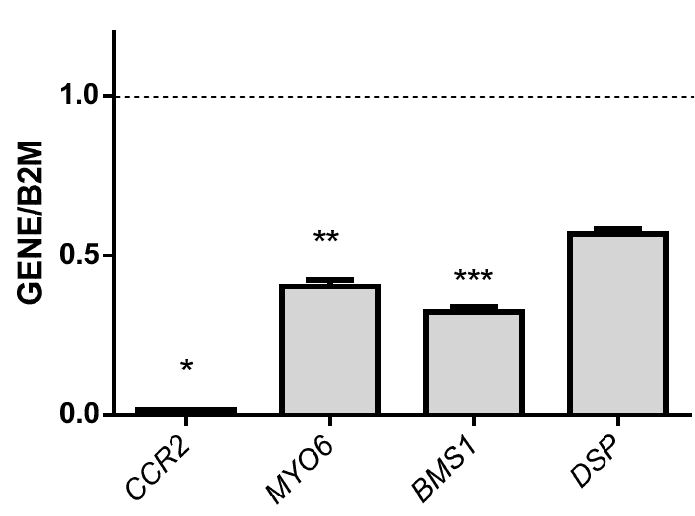
Figure 3. Levels of normalized mRNA of the down-regulated genes CCR2 , MYO6 , BMS1 and DSP in pediatric patients with epilepsy. The gene levels were normalized to the level of the housekeeping gene B2M and are expressed per 20 ng of total RNA. The values represent the means with standard deviations (SD) of the expression levels of each gene. We found significant differences between all genes. * p < 0.05 vs. the gene expression of MYO6 , BMS1 , and DSP ; ** p < 0.05 vs. the gene expression of BMS1 and DSP ; and *** p < 0.05 vs. the gene expression of DSP .